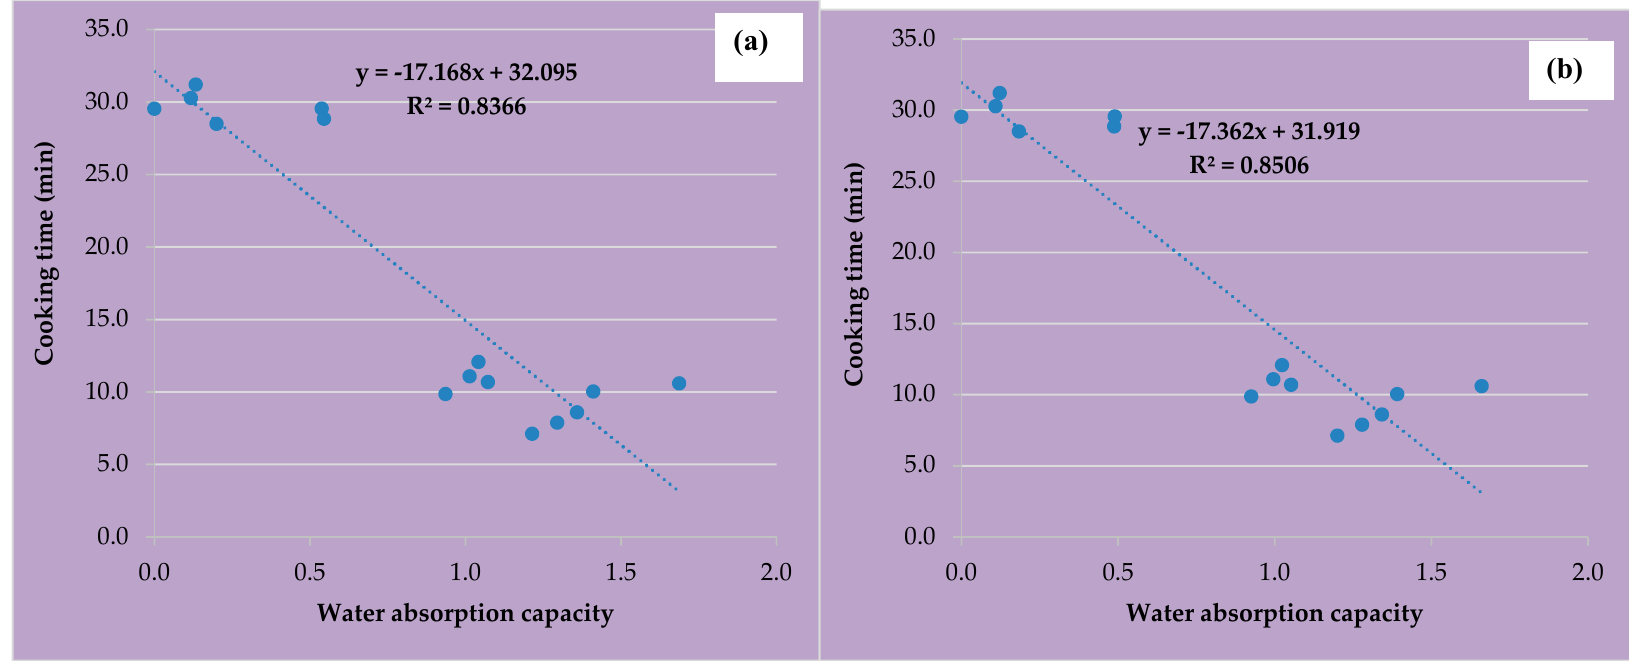
Figure 6. Correlation between water absorption and cooking time for the Vigna racemosa accessions. ( a ) Plotted with data from Site A; ( b ) plotted with data from Site